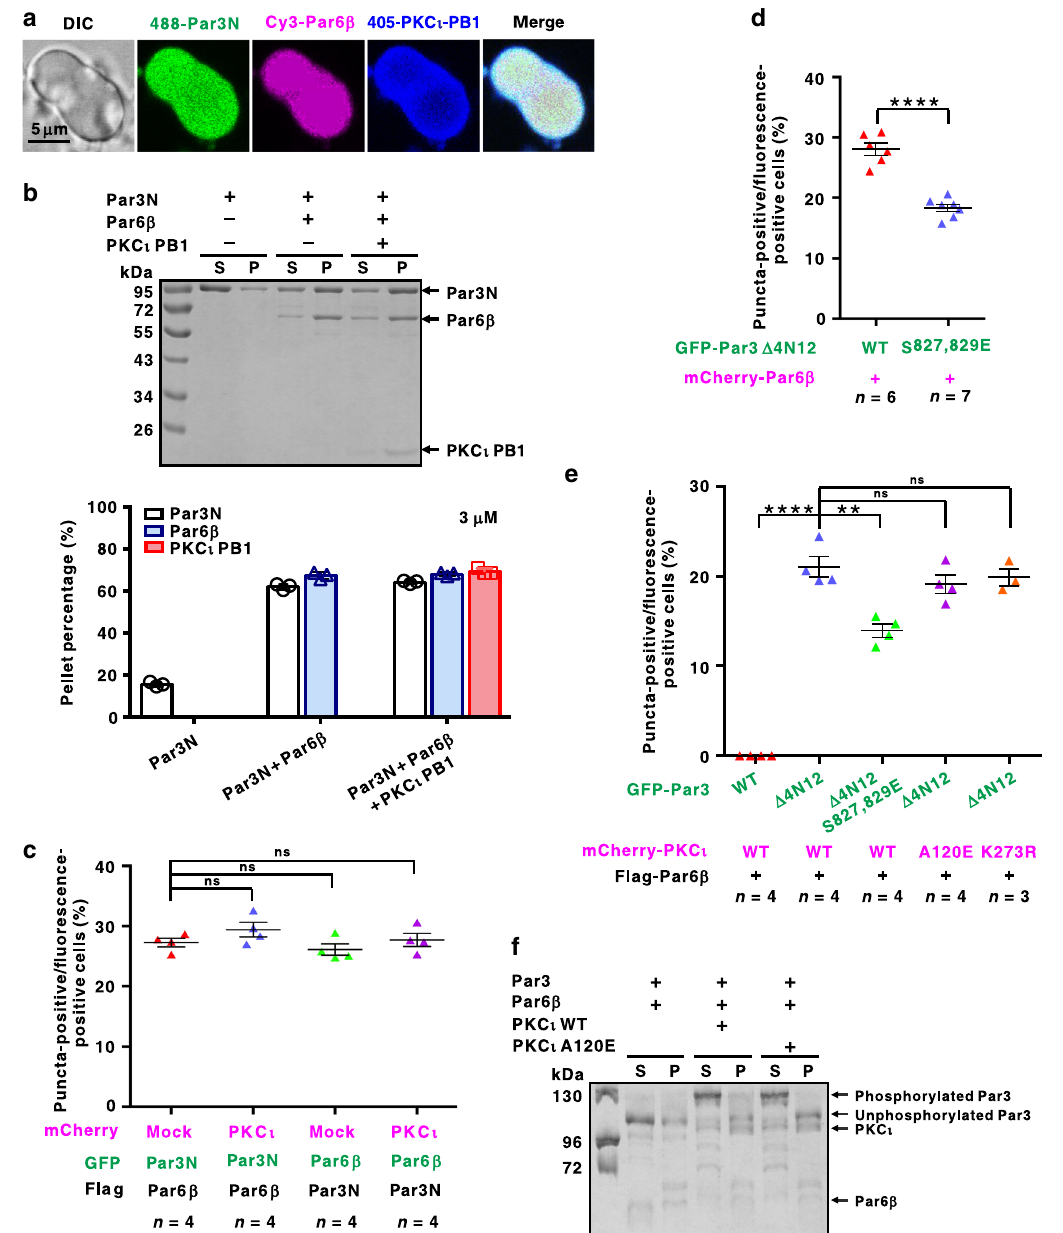
Fig. 6 PKC ι activity may regulate the LLPS of Par3N/Par6 β . a The fl uorescent images showing that the co-localization of iFluor TM 488-Par3N, Cy3- Par6 β , and 405-PKC ι PB1 in the droplets with enriched concentration. b Sedimentation assay and quanti fi cation data showing that PKC ι PB1 can participate the LLPS of Par3N/Par6 β complex as a client with no effect on the extent of LLPS. n = 3 biologically independent experiments. Data are represented as mean ± SD. c Puncta formation summary for co-localization and condensation of Par3N, Par6 β , and PKC ι in COS7 cells. Statistical data for Supplementary Fig. 5a. Co-expression of PKC ι full-length protein did not enhance or impair LLPS of Par3N/Par6 β . d Puncta formation summary for co-expression of GFP- Par3 Δ 4N12 WT or the aPKC phospho-mimetic S827,829E mutant with mCherry-Par6 β in COS7 cells. Statistical data for Supplementary Fig. 5b. e Puncta formation summary for co-expression of GFP-Par3 WT, Δ 4N12 or the phospho-mimetic Δ 4N12 S827,829E with Flag-Par6 β , and mCherry-PKC ι WT, the constitutively active A120E, or the kinase-dead K273R mutant in COS7 cells. Statistical data for Supplementary Fig. 5c. n = number of independent experimental cell culture batches, with 800 c , d or 600 e cells counted for each batch. Specimens ’ statistics are presented as mean ± SEM; ns, not signi fi cant; * p < 0.05, ** p < 0.01, *** p < 0.001, and **** p < 0.0001 using one-way ANOVA with Tukey ’ s multiple comparison test. f Sedimentation assay showing the distribution of proteins (Par3 1 – 854, Par6 β , PKC ι WT, or A120E mutant) between aqueous solution/supernatant (S) and condensed liquid phase/pellet (P) fractions. Both PKC ι WT and A120E mutant phosphorylated Par3 1 – 854 in the supernatant fraction but not in the pellet fraction. The band of phosphorylated Par3 1 – 854 was resolved by Phos-tag PAGE. Experiments were performed three times independently with similar results. Source data are provided as a Source data fi